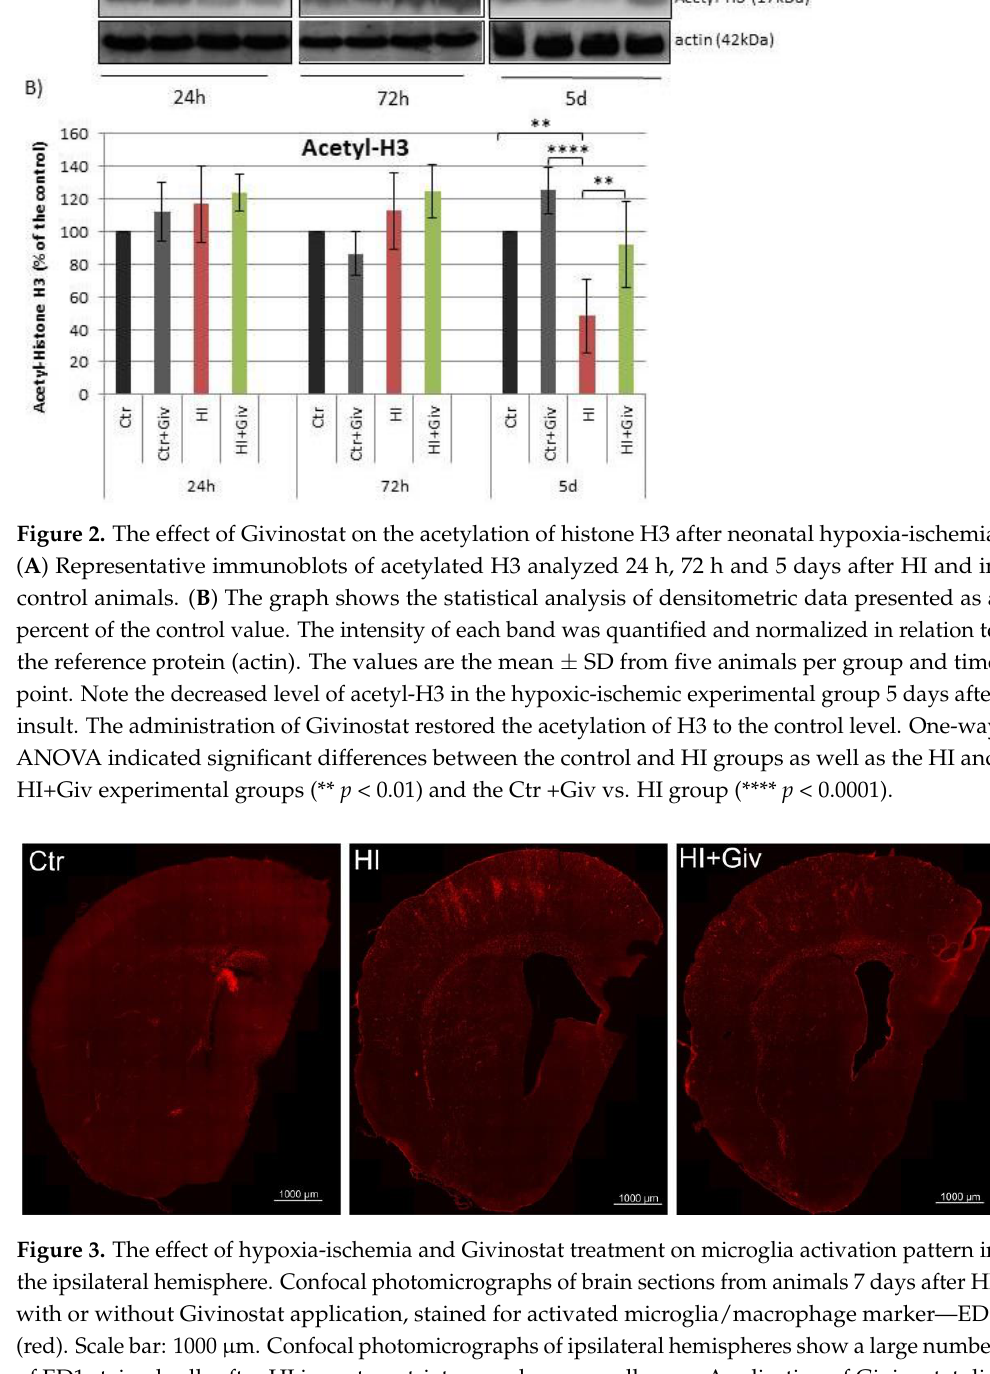
Figure 4. Givinostat has no effect on the polarization of microglia after neonatal hypoxia-ischemia. Sections from ipsilateral (hypoxic-ischemic) hemispheres 7 and 14 days after HI were stained for